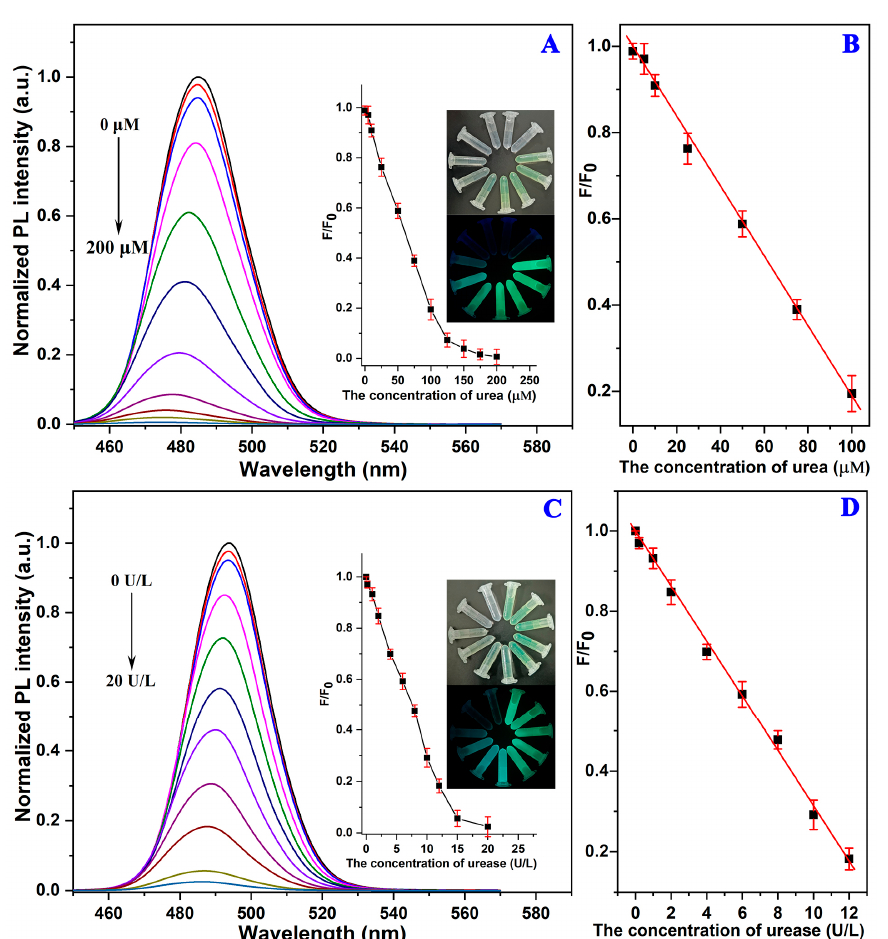
Figure 5. ( A ) Fluorescence emission spectra of Au NWs sensing system upon adding various concentrations of urea at 12 U/L urease (from top to bottom: 0, 5, 10, 25, 50, 75, 100, 125, 150, 175, and 200 µ M, respectively), The inset of ( A ) showed the corresponding photographs and relationship between the fluorescence intensity ratio F/F 0 and varied levels of urea. ( B ) Linear correlation between F/F 0 and urea concentrations. ( C ) Fluorescence emission spectra of Au NWs sensing system upon adding various concentrations of urease at 500 µ M urea (from top to bottom: 0, 0.2, 1, 2, 4, 6, 8, 10, 12, 15 and 20 U/L, respectively). The inset of ( C ) showed the corresponding photographs and relationship between the fluorescence intensity ratio F/F 0 and varied levels of urease. ( D ) Linear correlation between F/F 0 and urease activities.